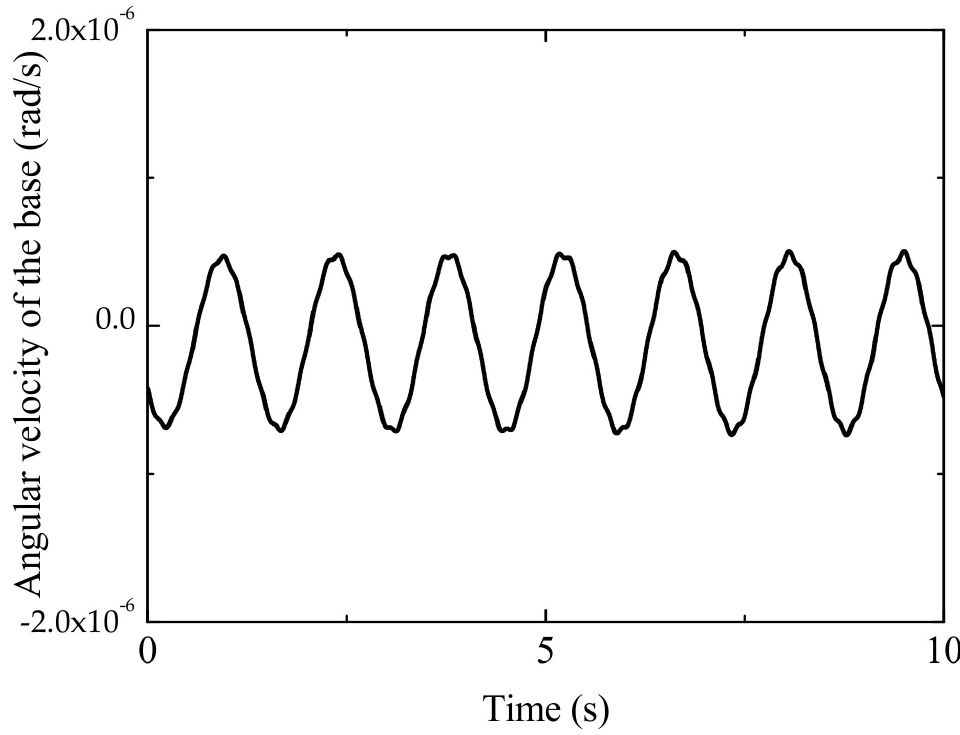
Figure 21. Angular velocity of the base in the trajectory tracking